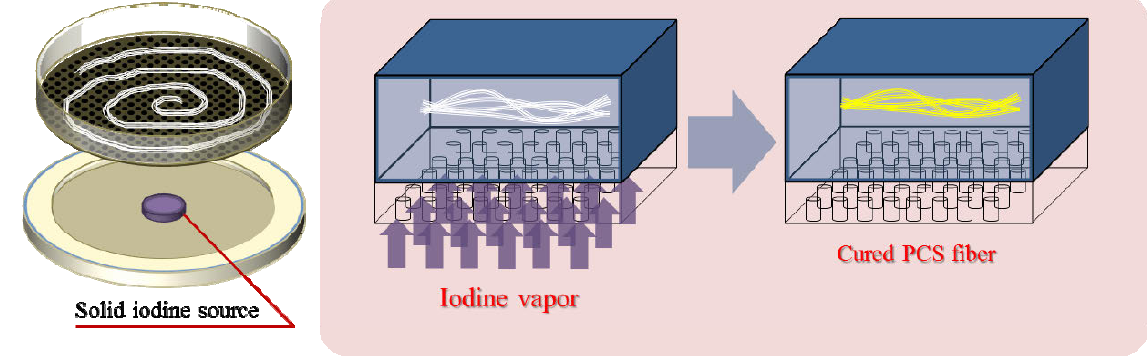
Fig. 1 Illustration of iodine vapor curing process.